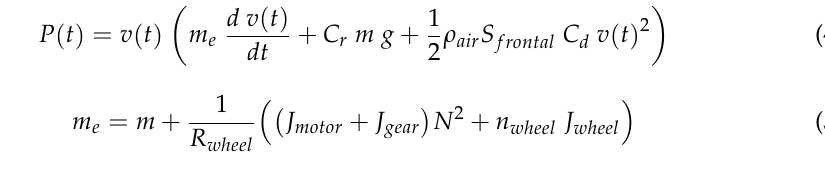
Table 1. Dataset used to translate the vehicle speed into power consumption.